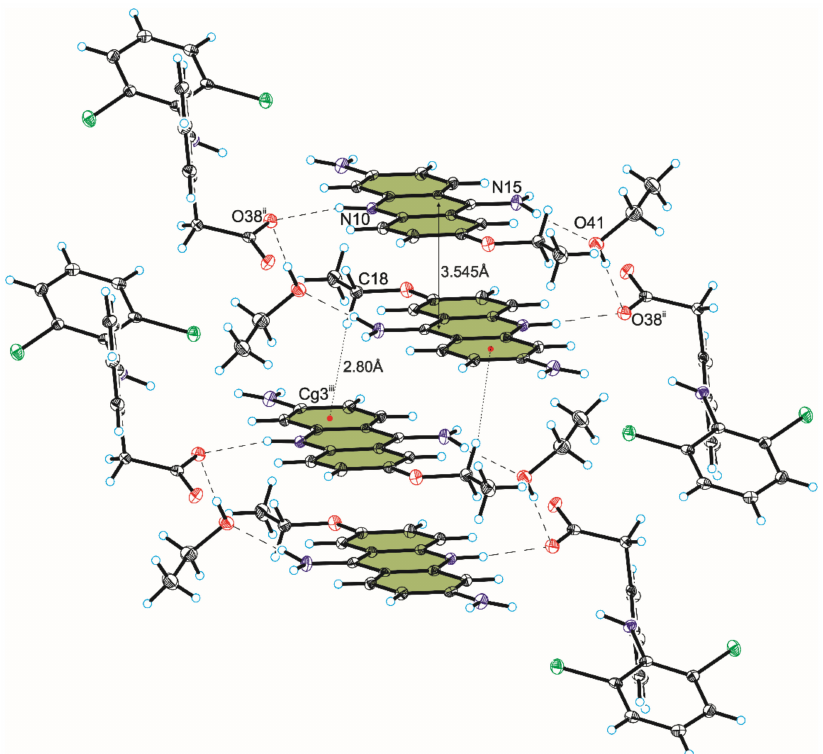
Figure 5. Heterohexamer formed by ethoxyacridinium and diclofenac ions and ethanol molecule in compound 2 (hydrogen bonds are represented by dashed lines, whereas C–H · · · π interactions are represented by dotted